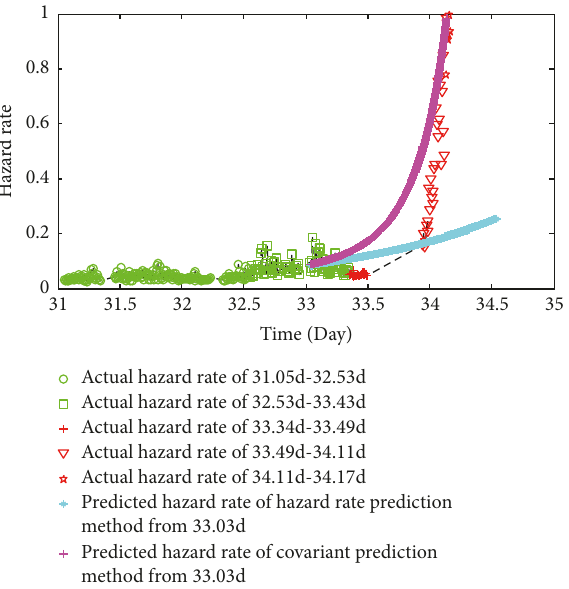
Figure 16: The trend prediction result of period (c).